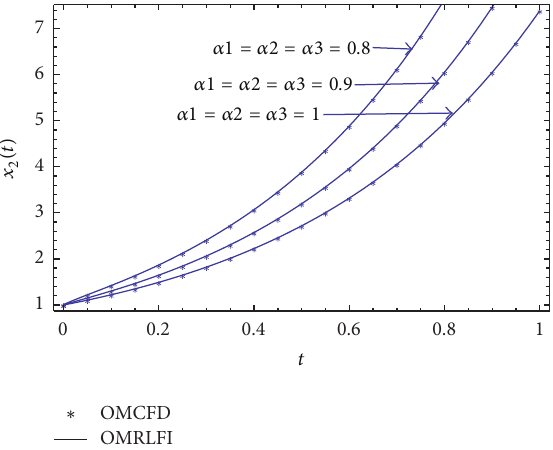
Figure 9: Approximate solutions of 𝑥 1 (𝑡) for 𝑚 = 10 and different values of 𝛼 1 , 𝛼 2 , 𝛼 3 by OMCFD and OMRLFI in Example 14.